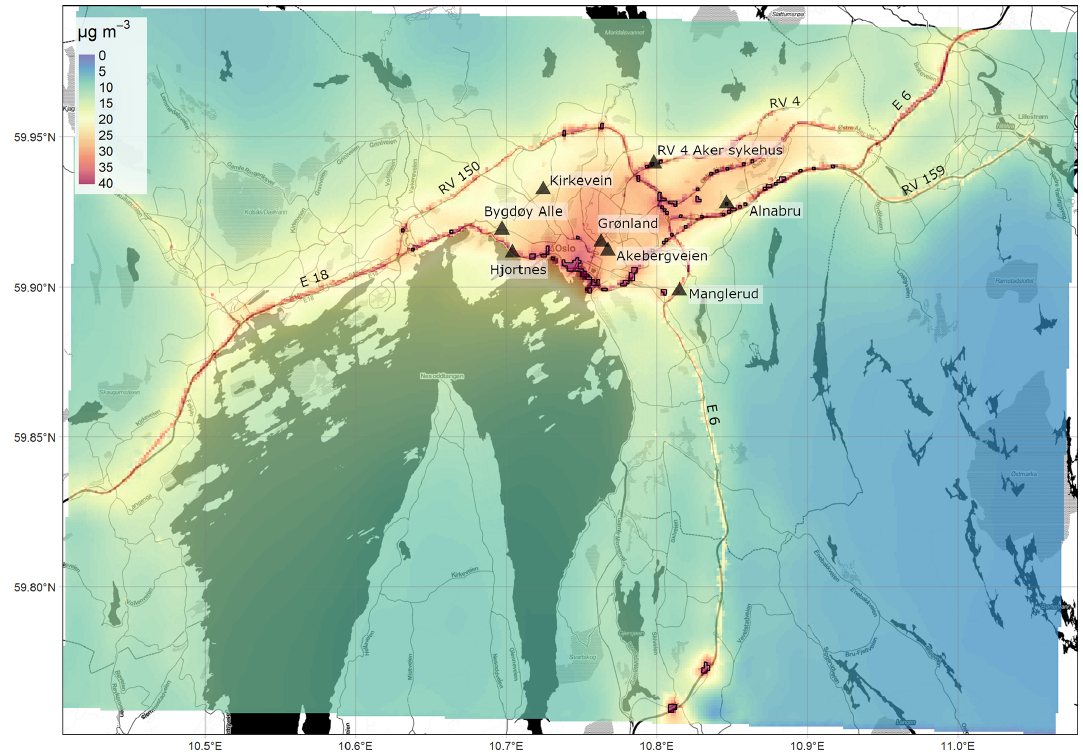
Figure 4. Annually averaged NO 2 concentrations (µgm − 3 ) from the EPISODE model over the Oslo domain at 100m × 100m horizontal resolution. The concentrations are derived from the receptor point concentrations and then re-gridded onto a 100m grid. The colour scale shows the range in annual mean NO 2 concentrations between 0 and 40µgm − 3 . The black triangles indicate the locations of the air quality observation stations (Table 7). The dark shaded areas represent the sea, lakes, and rivers. The black lines are roads. © OpenStreetMap contributors 2019. Distributed under a Creative Commons BY-SA